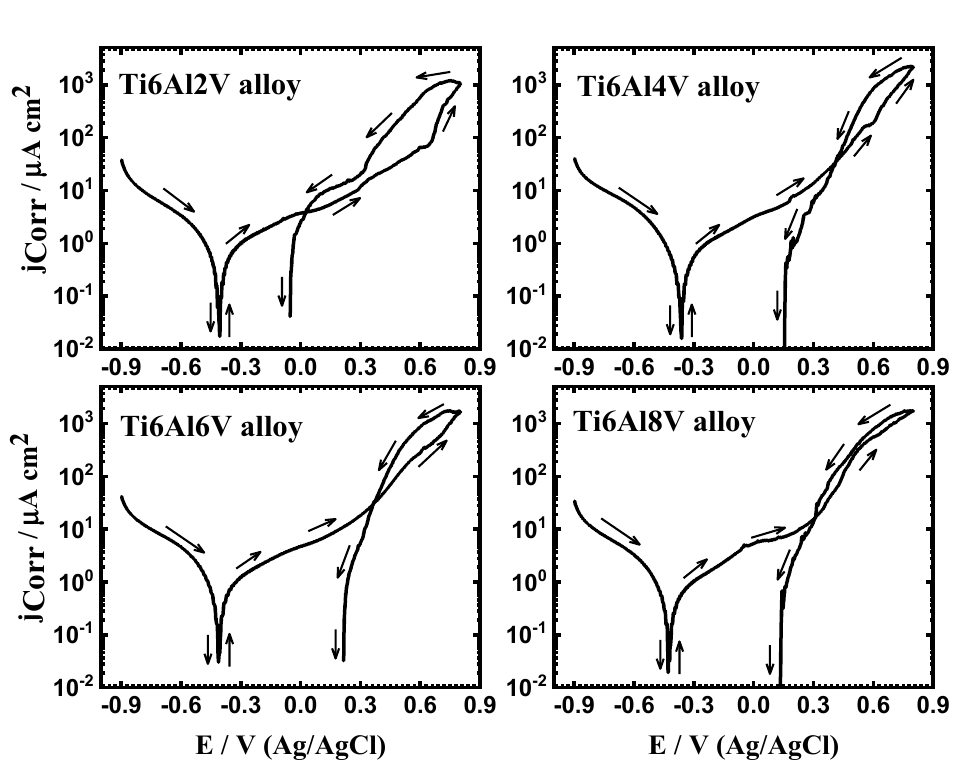
Figure 5. The cyclic potentiodynamic polarization (CPP) plots of the di ff erent TiAlV alloys after 1 h immersion in the NaCl